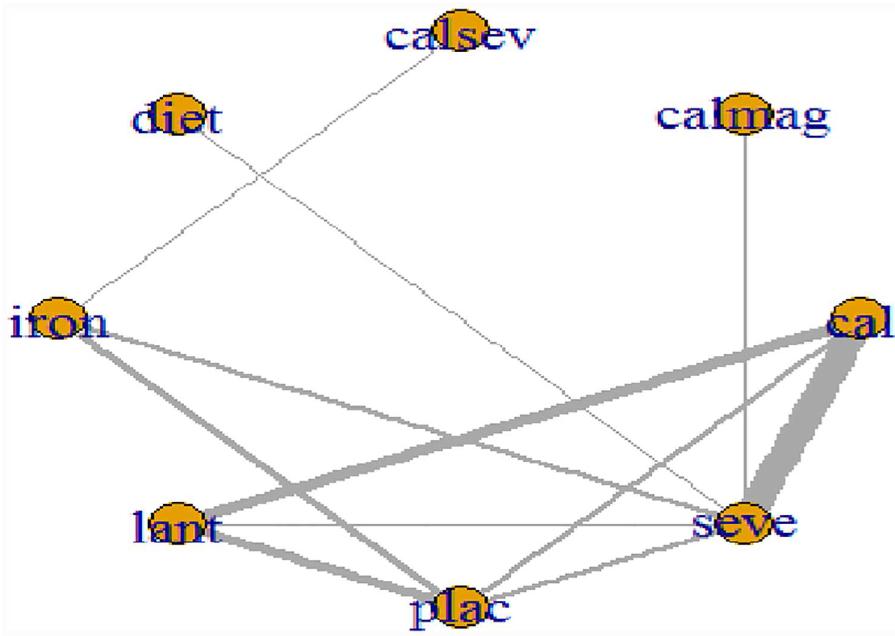
Fig 6. Network of clinical trials of phosphate binders in patients with chronic kidney disease: outcome mean change from baseline in serum calcium concentration. Netplot of effectiveness outcome for mean calcium reductionat the end of the study period. Network of randomized controlledtrials comparing different phosphatebindersfor mean changein serum calcium. Lines connect different phosphate binder categories with direct evidence.The width of lines correlates the numberof RCTs for each direct comparison whilethe size of the nodes correlates with the total sample size. Abbreviations: cal: calcium; calmag: calcium and magnesium; calsev: calcium and Sevelamer; Lant: lanthanum;seve: